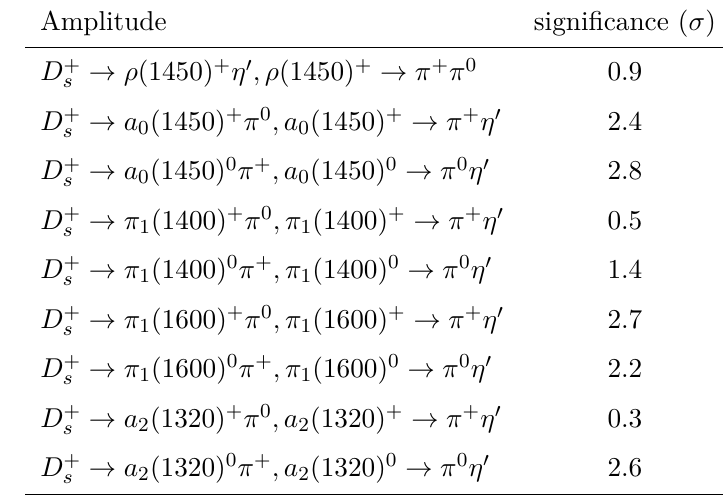
(left), M (middle) and M (right) of the nominal fit. Figure 5 . Projections on M η 0 π + η 0 π 0 π + π 0 The data are represented by points with error bars, the fit results by the blue solid line, and the background events of signal-subtracted inclusive MC sample by the black dashed line.